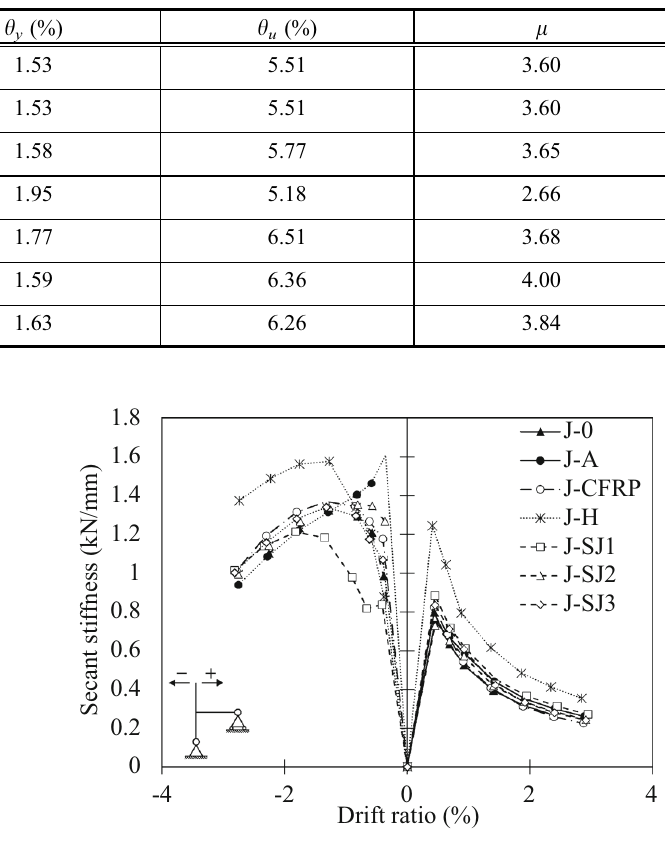
Fig. 19 Stiffness degradation